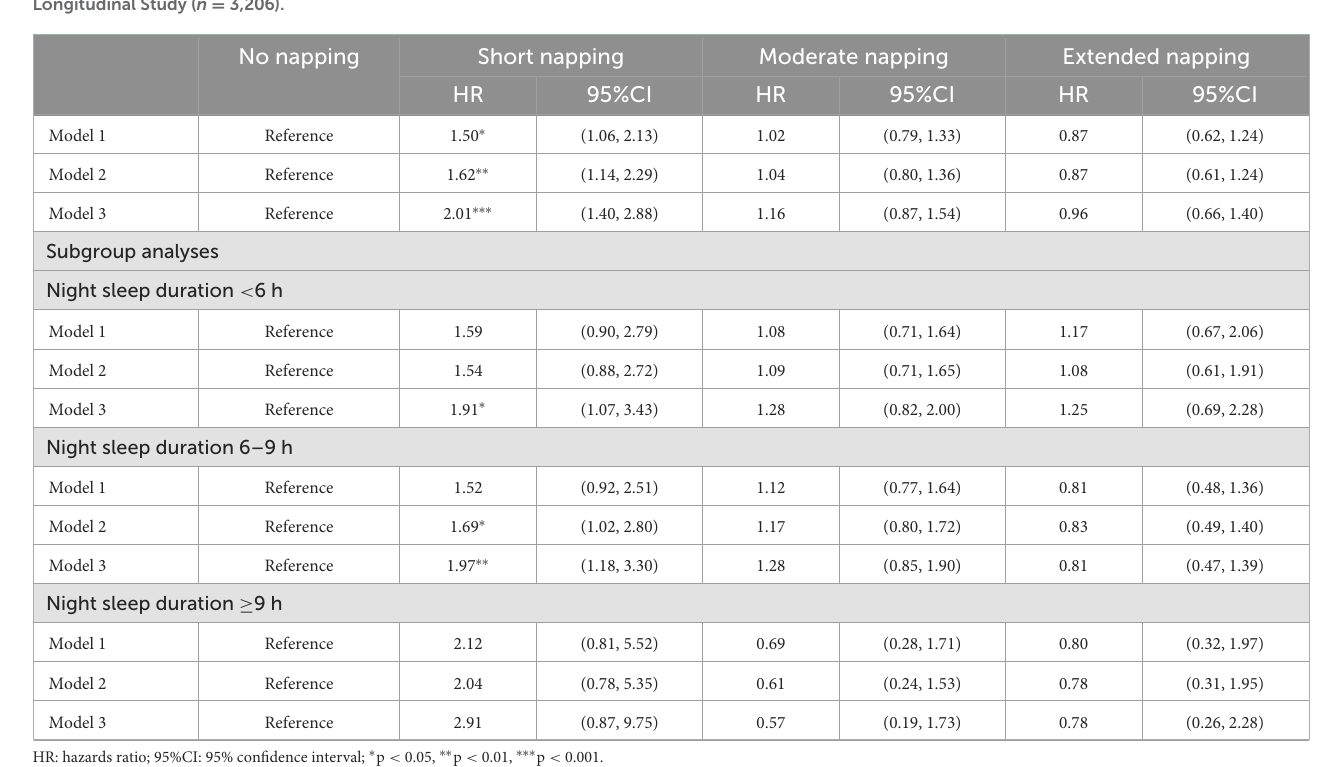
TABLE 3 Association of daytime nap duration and incident frailty in the follow-up surveys (wave2–wave3) from the China Health and Retirement Longitudinal Study ( n =